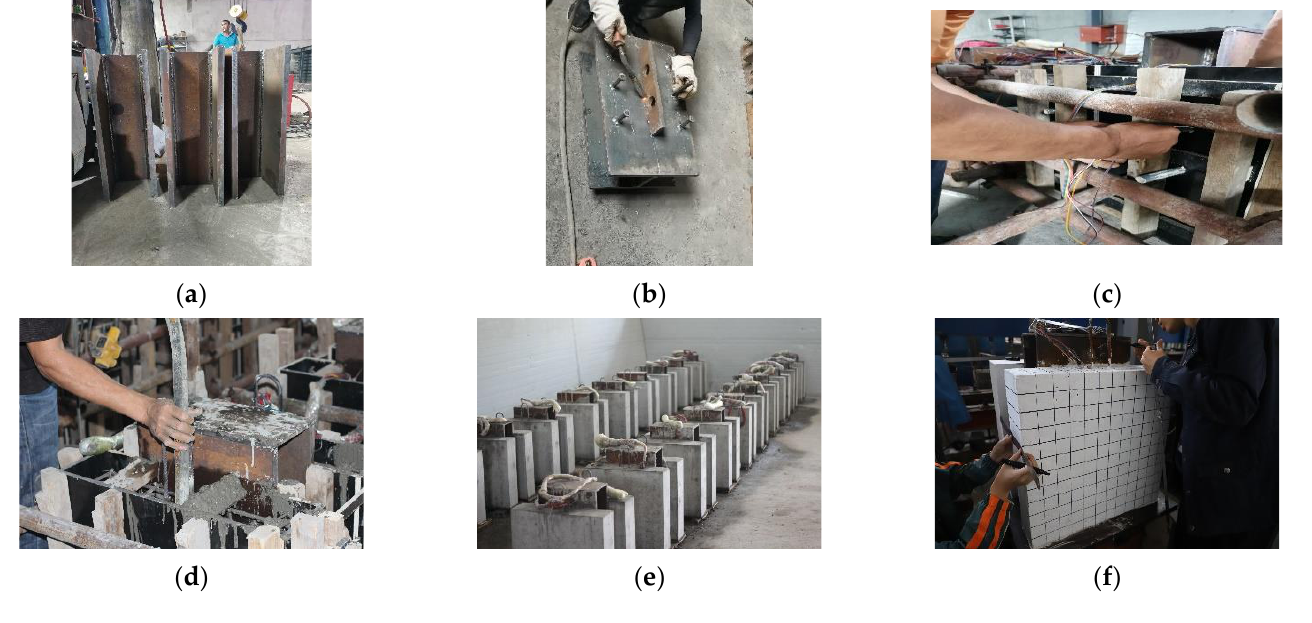
Figure 3. Fabrication of specimens: ( a ) machining H-beams; ( b ) welding perforated steel plate; ( c ) fixing penetrating rebar; ( d ) pouring concrete; ( e ) curing concrete; ( f ) drawing